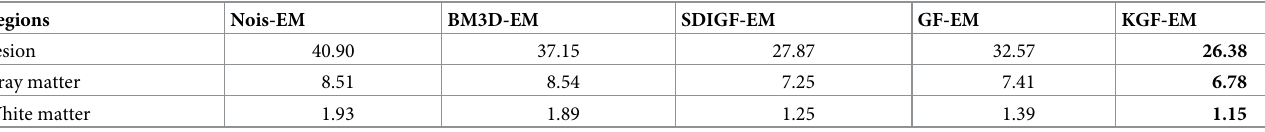
Table 1. MAEs of MLEM reconstructed images from noisy and denoised sinogram datasets.